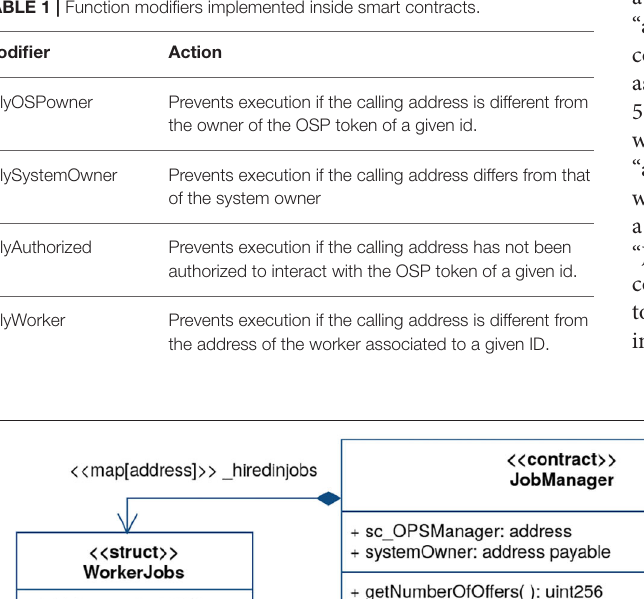
TABLE 1 | Function modifiers implemented inside smart contracts.